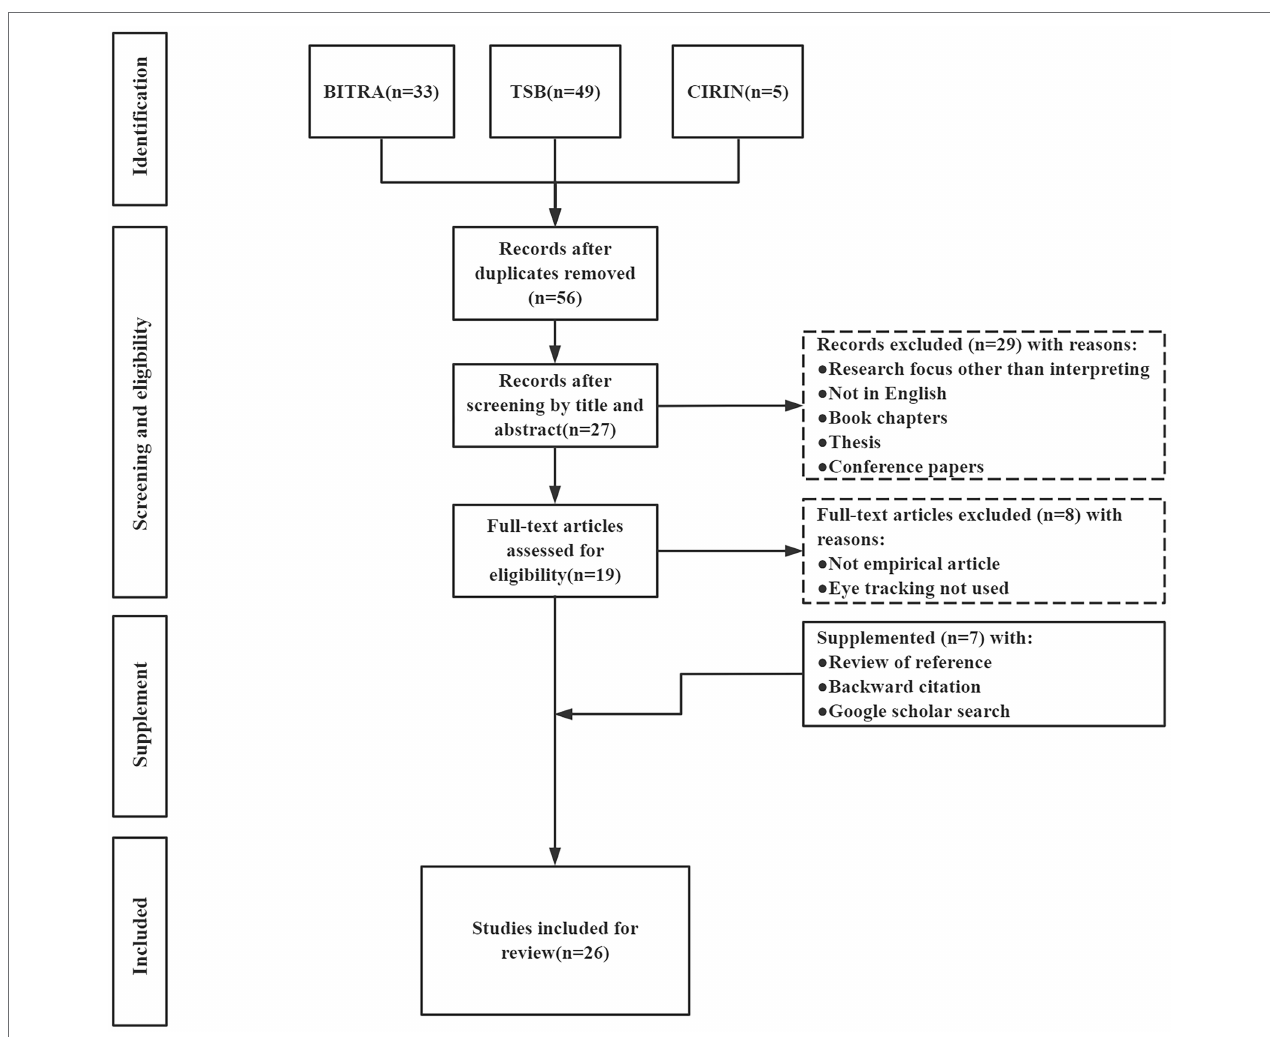
FIGURE 1 | Flow diagram depicting paper selection